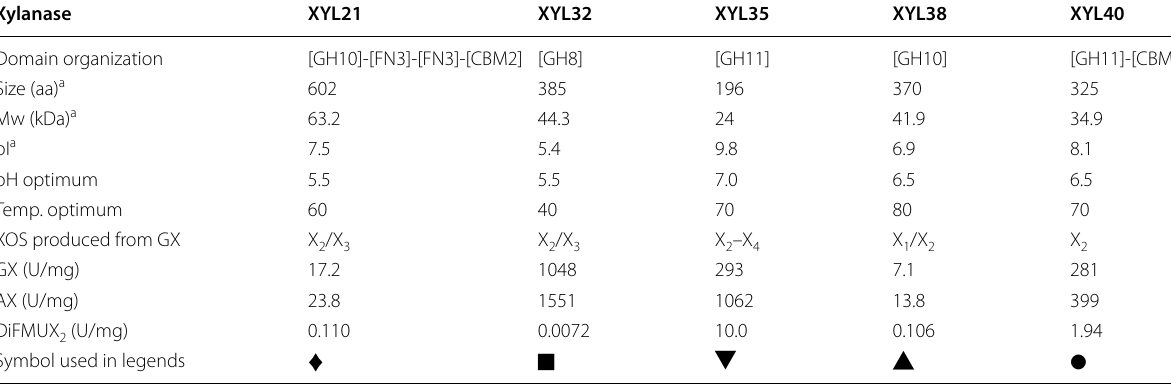
Table 3 Characteristics of the purified recombinant